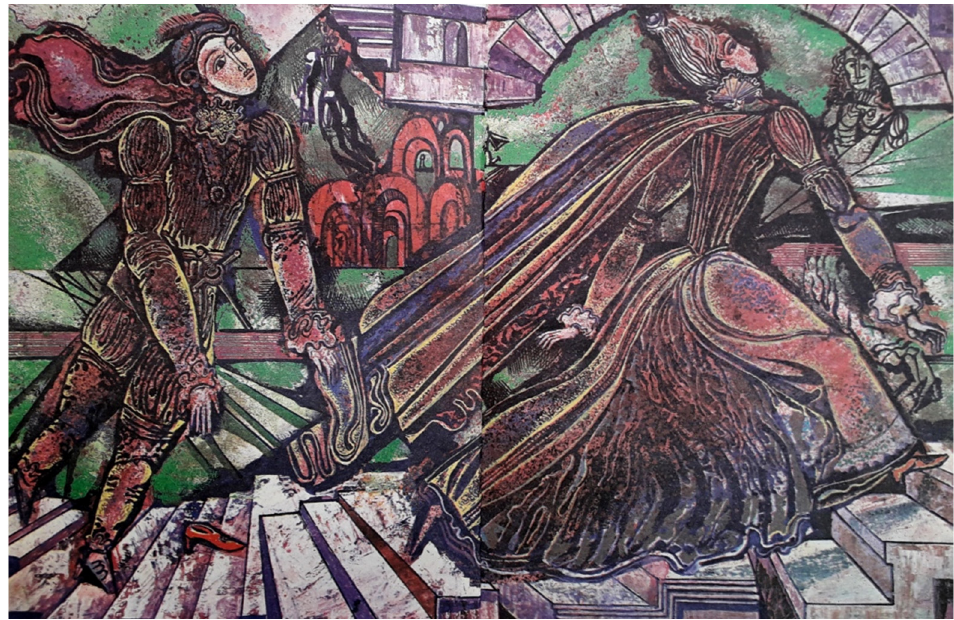
Figure 2. Illustration of The Brothers Grimm fairy tales (Cinderella), 1978. Illustrated by Stoyan Iliev, Sofia: Narodna Mladezh.